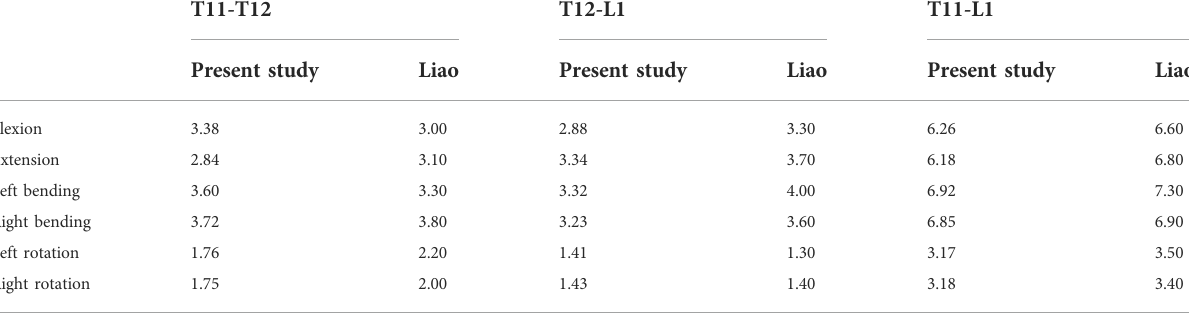
TABLE 3 Comparison of the ROM of T11 – T12, T12 – L1 and T11-L1 with published study of Liao (Liao, 2020) (unit: degree). T11-T12 T12-L1 T11-L1 Present study Liao Present study Liao Present study